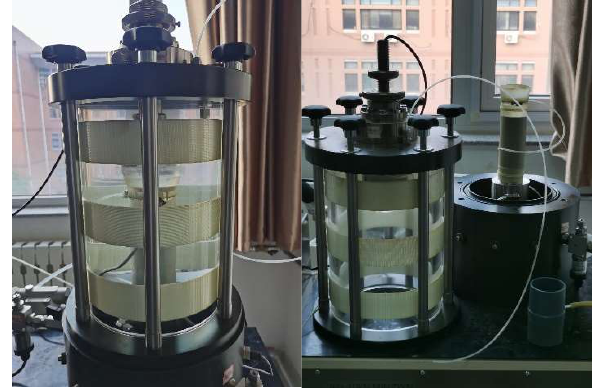
Figure 2. The complete device.